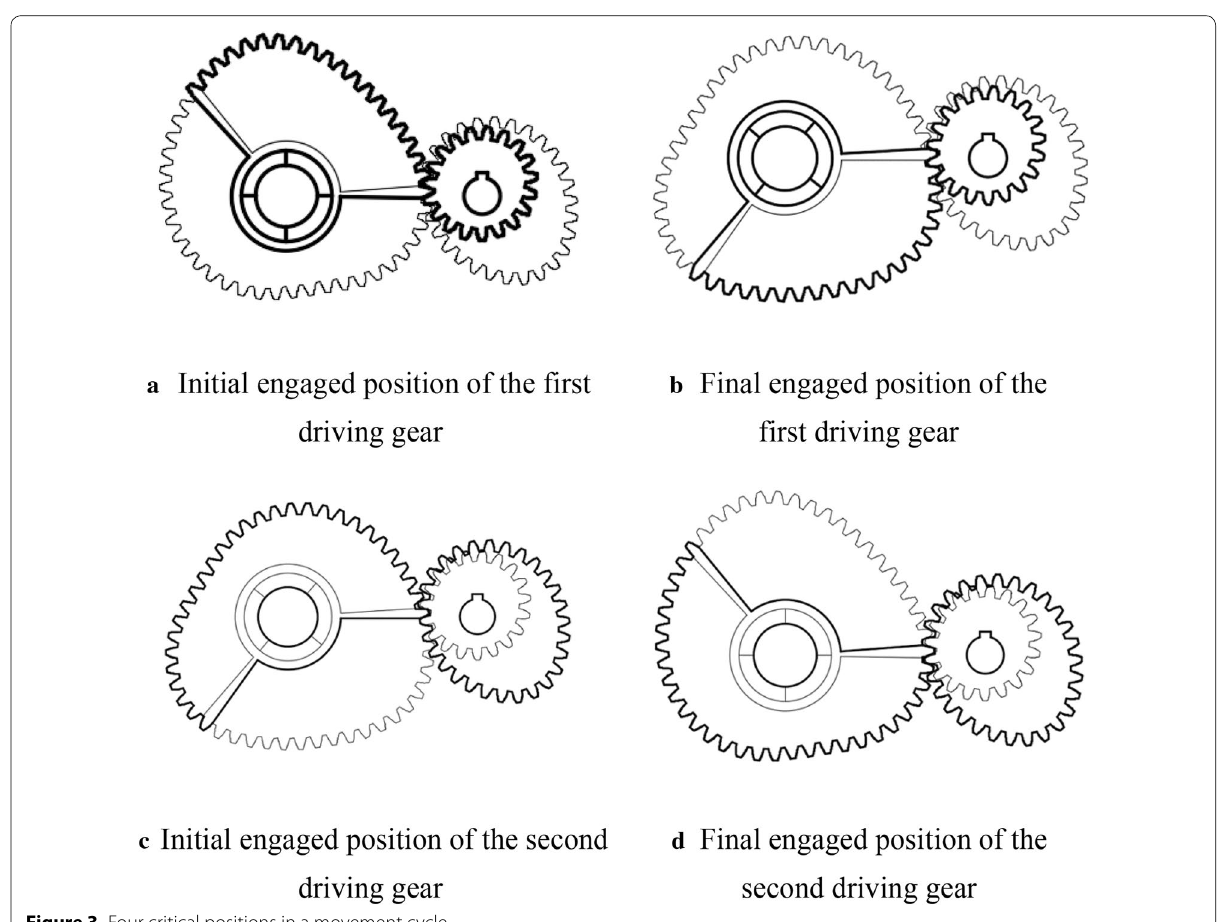
Figure 3 Four critical positions in a movement cycle